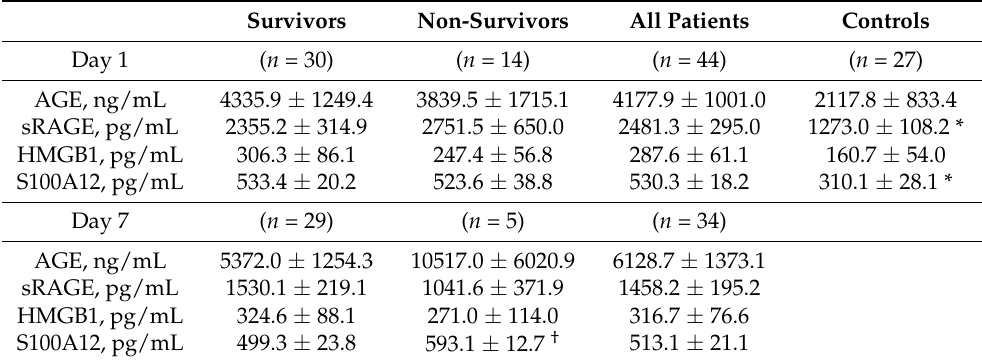
Table 2. Plasma AGE, sRAGE, and HMGB1 levels (mean ± standard error mean) on Days 1 and 7 in survivors, non-survivors, and controls.